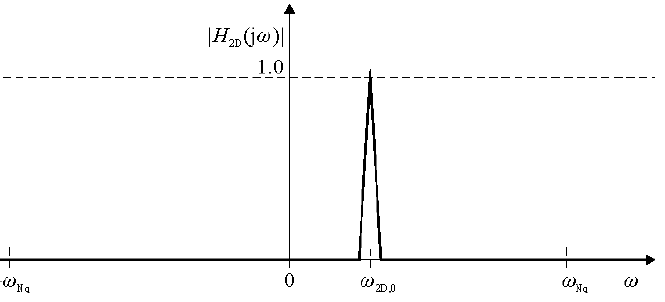
Figure 1. Magnitude is part of the theoretical transfer function of the 2D-FIR.